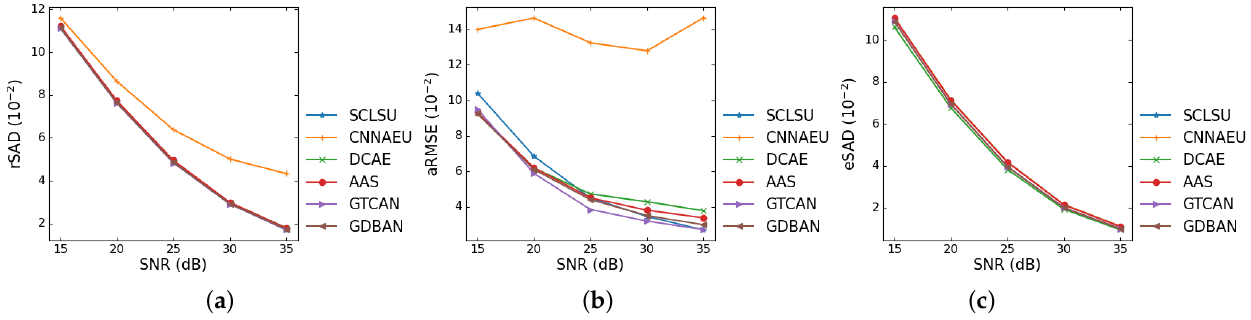
Figure 5. Robustness analysis with the different SNRs. ( a ) rSAD. ( b ) aRMSE. ( c )